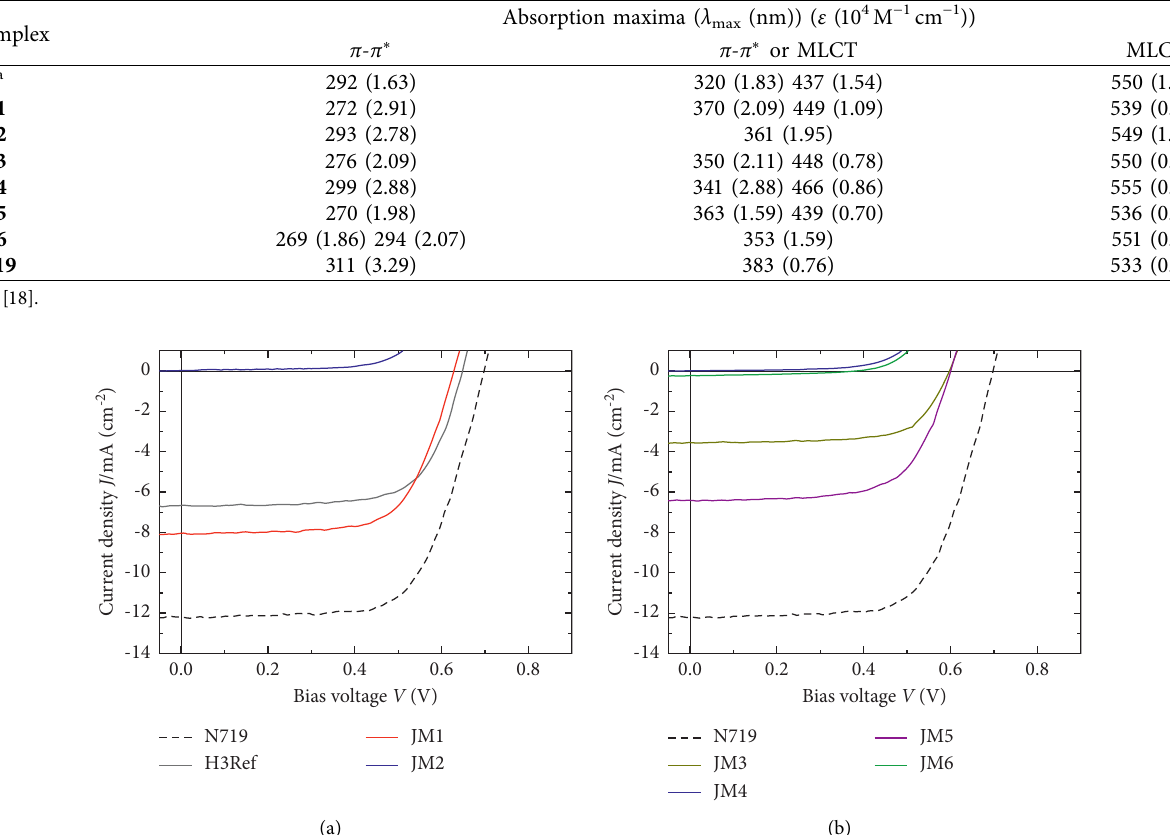
2 nanocrystalline solar cells under